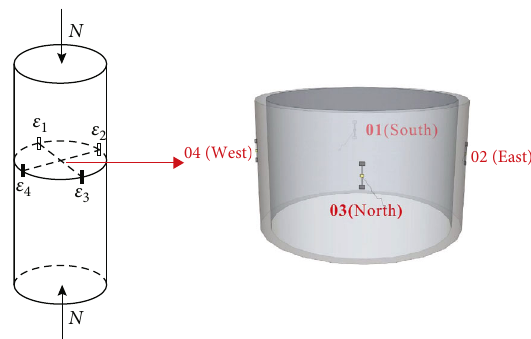
Figure 6: Schematic diagram of the axial force calculation.